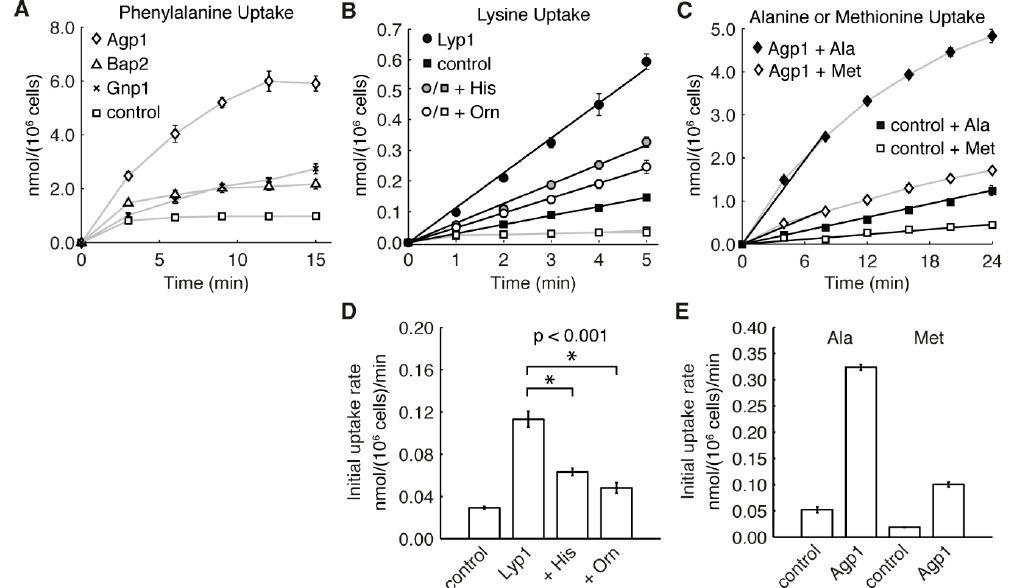
Figure 3. Amino acid uptake by S. cerevisiae cells. Transporters were expressed from the constitutive ADH1 promoter with a C-terminal YPet tag. BY4709 carrying the empty plasmid pRSII426 was used as a vector control strain. ( A ) Uptake of phenylalanine (2.5 mM). ( B ) Uptake of lysine (50 µM) in the absence (black symbols) or presence of histidine (100 mM, grey symbols) or ornithine (100 mM, white symbols); circles, Lyp1 overexpression; squares, vector control strain. ( C ) Uptake of either alanine (500 µM, black symbols) or methionine (500 µM, white symbols); diamonds, Agp1 overexpression; squares, vector control strain. The straight black lines in ( B , C ) represent the calculated initial uptake rates, which are shown in ( D , E ), respectively. Values are the mean of biological triplicates. Error bars represent standard deviation and, in some cases, are obscured by the data point. Rates in ( D ) were compared using a t -test, and asterisks (*) represent p < 0.001.